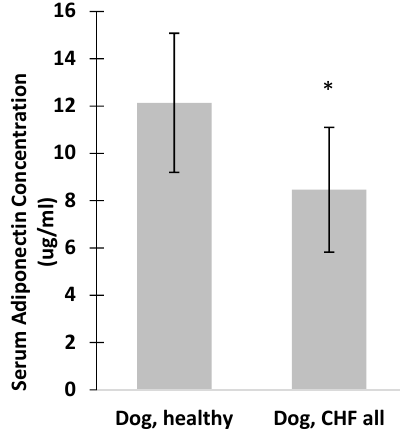
Figure 2. Mean serum adiponectin concentration was significantly higher in healthy dogs ( n = 18) than in dogs with all classes of CHF ( n = 18), * p = 0.001.